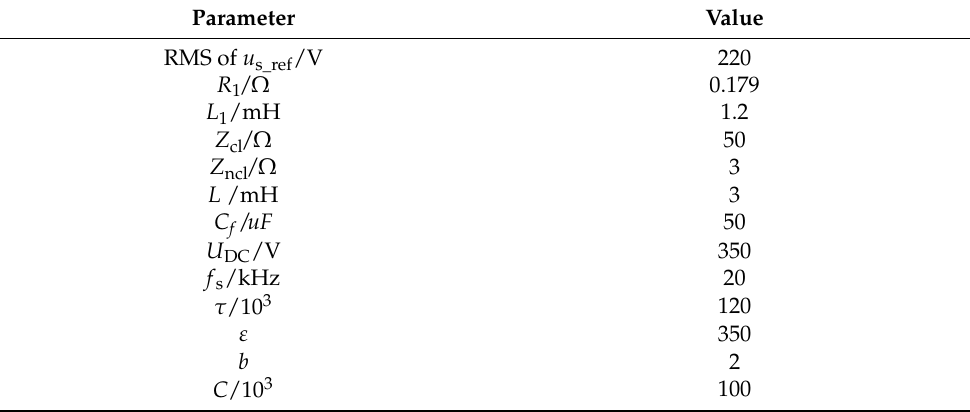
Table 1. Simulation parameters for the electrical and control systems of the